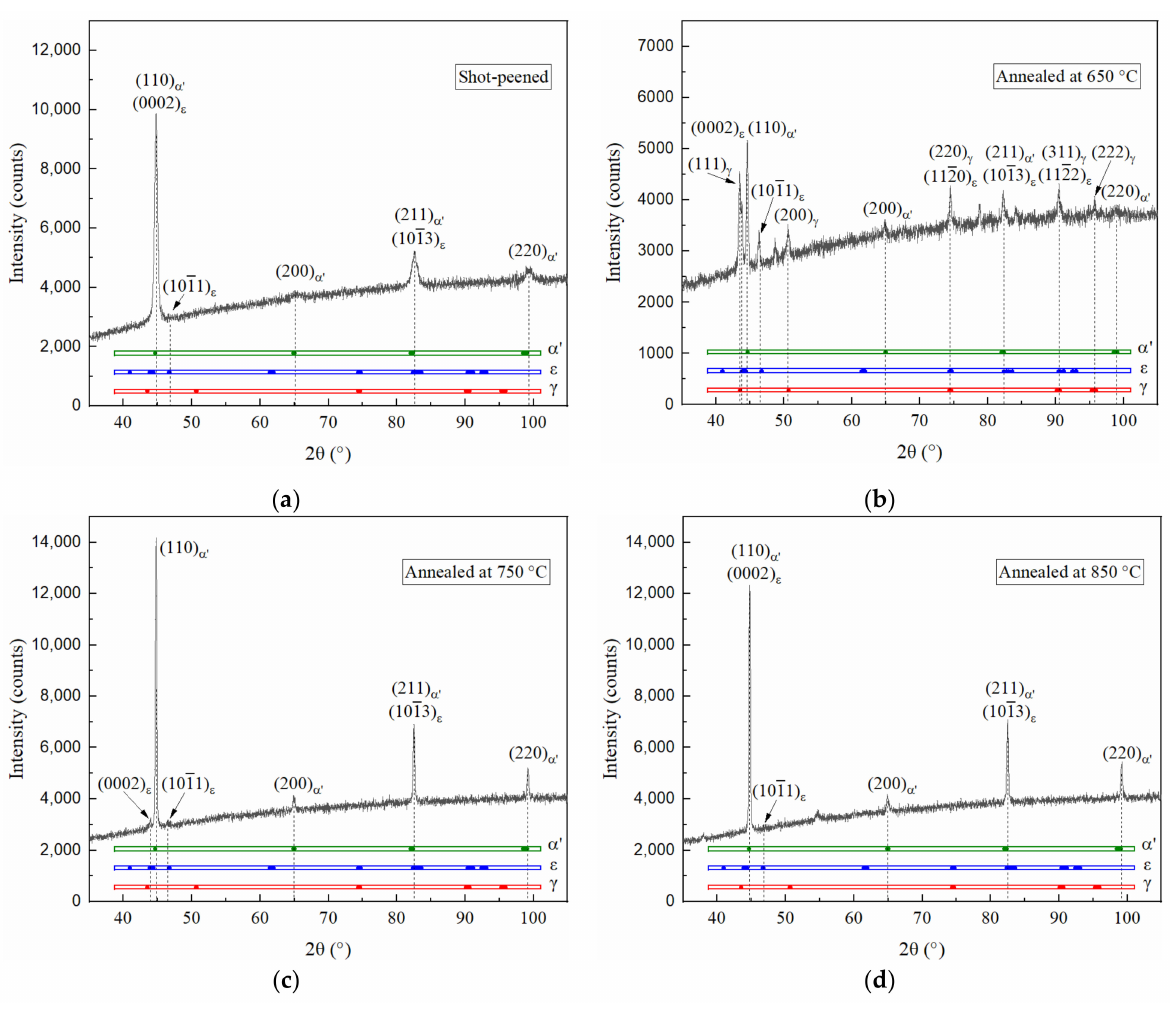
Figure 3. XRD patterns of ( a ) the shot-peened specimen and the subsequently annealed specimens with annealing temperatures of ( b ) 650 ◦ C, ( c ) 750 ◦ C, and ( d ) 850 ◦